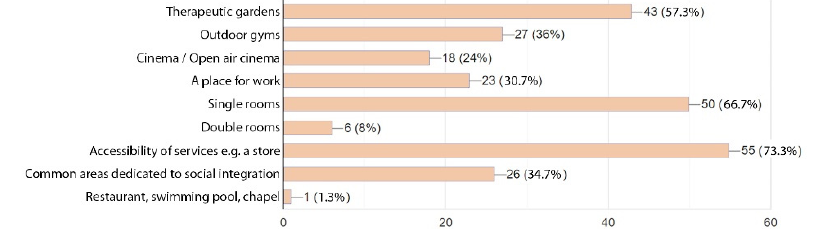
Figure 14. Spatial expectations—alternative amenities—patients.